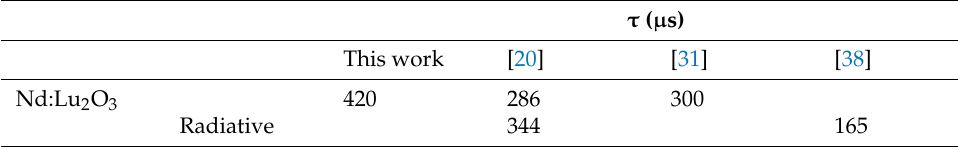
Table 8. Decay time of 1%Nd:Lu 2 O 3 .